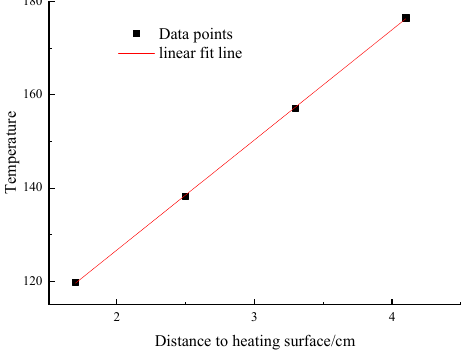
Figure 3. Schematic of the linear fit of the longitudinal temperature.